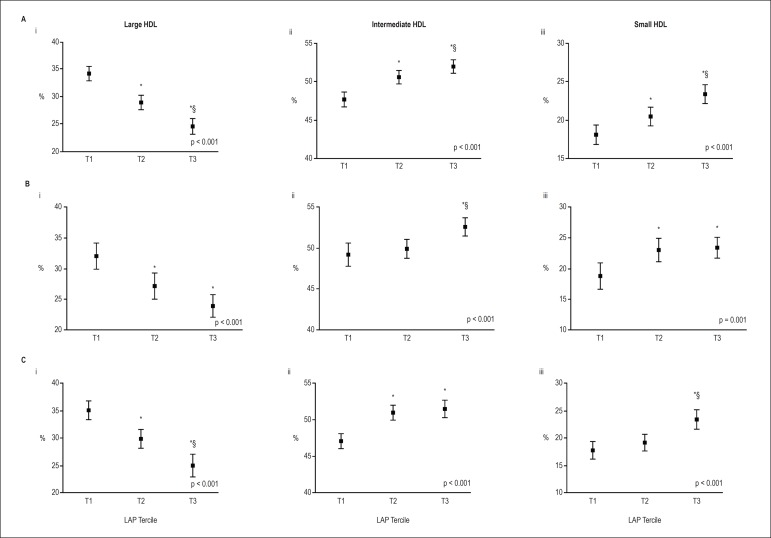
Percentages of large, intermediate, and small HDL (high density
lipoprotein) particles, according to the LAP (lipid accumulation
protein) tertiles. A) Adjusted by sex, age, smoking, statin, fibrate,
and hypoglycemic drugs. B) Men, adjusted by age, smoking, statin,
fibrate, and hypoglycemic drugs (n = 132). C) Women, adjusted by age,
smoking, statin, fibrate, and hypoglycemic drugs (n = 219). i: Larger
HDL. ii: Intermediate HDL. iii: Small HDL. Data are presented as mean
and 95% confidence interval. Comparative analysis was performed using
the linear trend test. LAP tertiles: T1 ≤ 45.5; 45.5 < T2
≤ 80.3; T3 > 80.3. HDL - high-density lipoprotein, LAP: lipid
accumulation product, % - percentage. Comparison between groups was
performed by ANOVA or Kruskal-Wallis and multiple comparisons by Tukey
test. *versus T1, §versus T2.
Significance level adopted for all analysis p < 0.05.